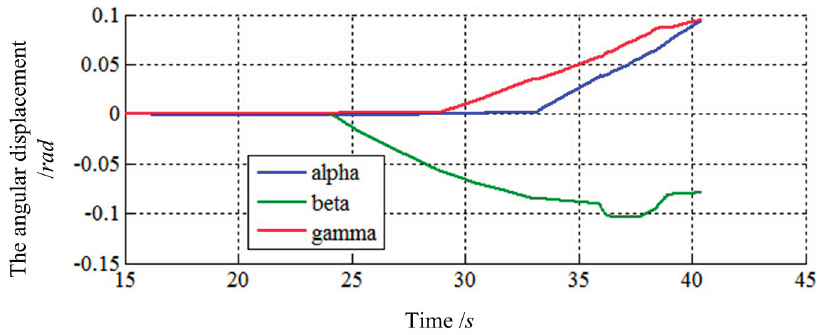
Figure 25. The angular displacement of load sensing ring based on Equation